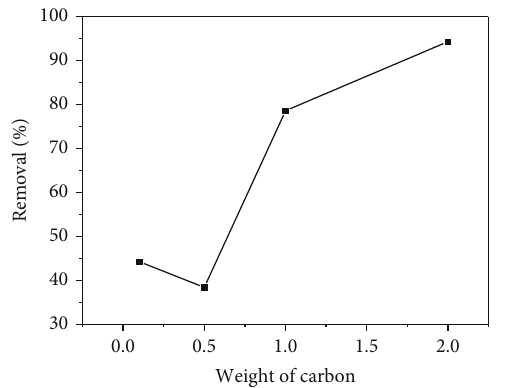
Figure 4: E ff ect of the initial concentration of iron